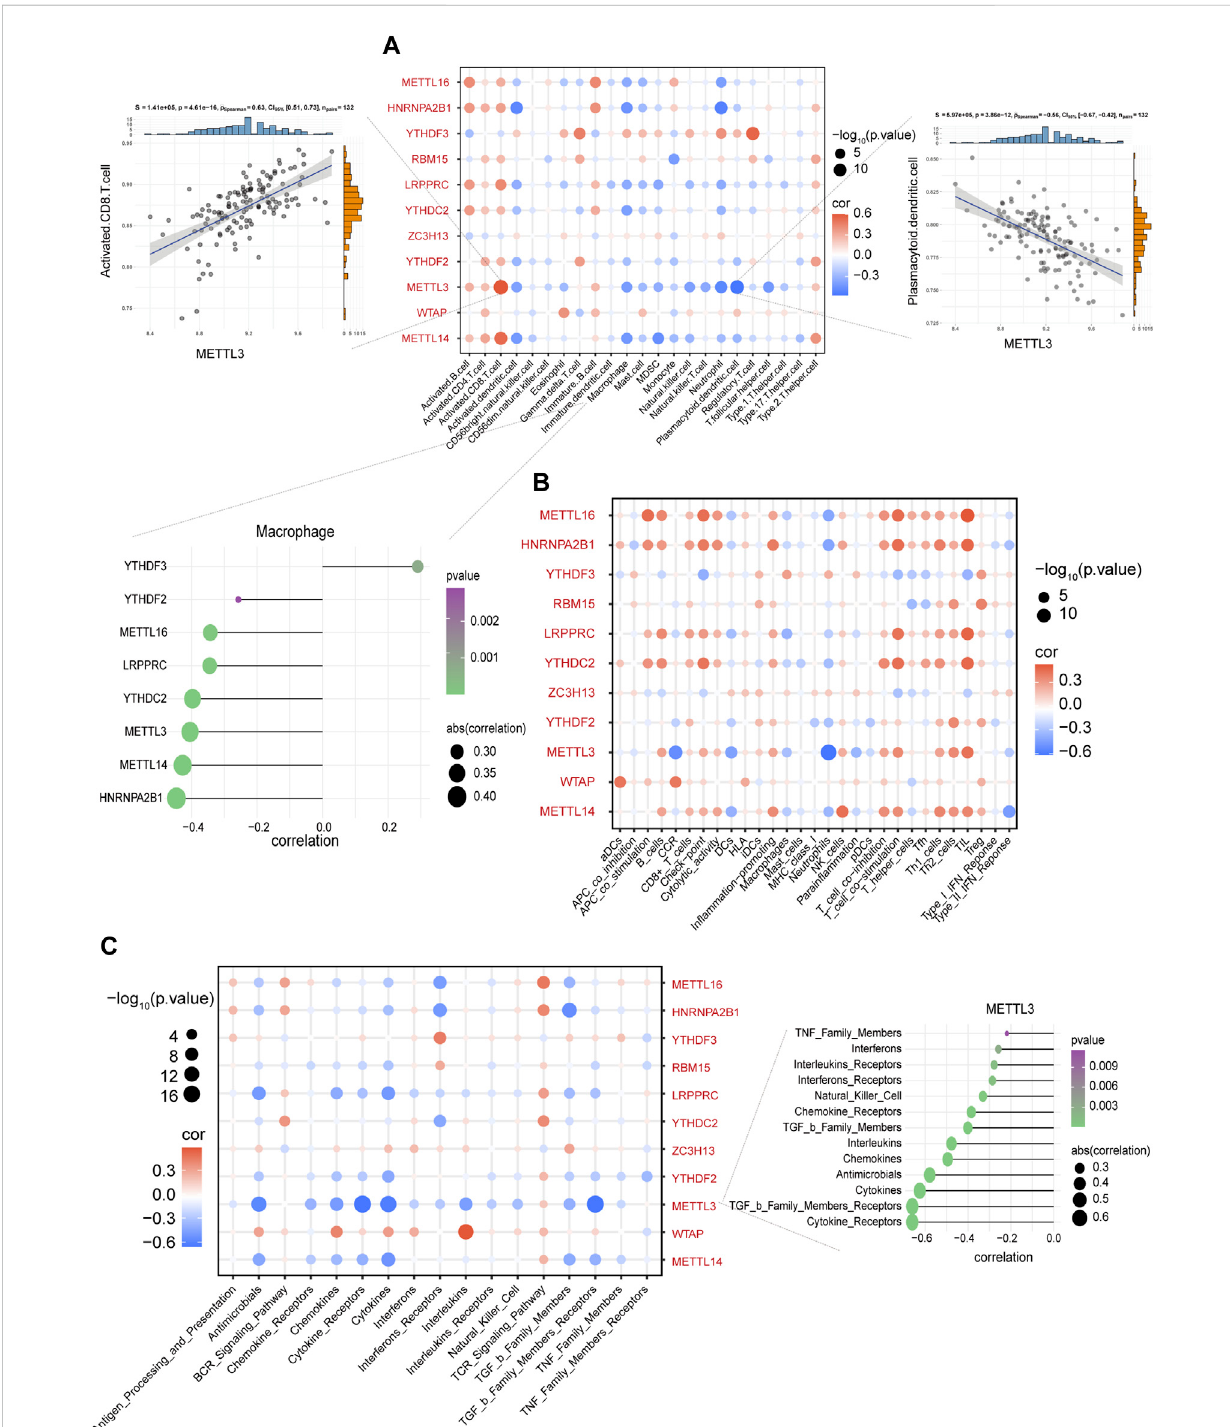
FIGURE 4 Macrophages were negatively correlated with most m6A regulators. (A) The correlation between immune cells and m6A regulators. METTL3 and activated CD8 T cells with the most negative correlation (left side scatter plot), and plasmacytoid dendritic cells with the most negative correlation (right side scatter plot). The lollipop plot presents macrophages and most m6A regulators with negative correlation. (B) The correlation between immune functions and m6A regulators. (C) The correlation between immune responses and m6A regulators. The lollipop plot presents METTL3 and most immune responses with negative